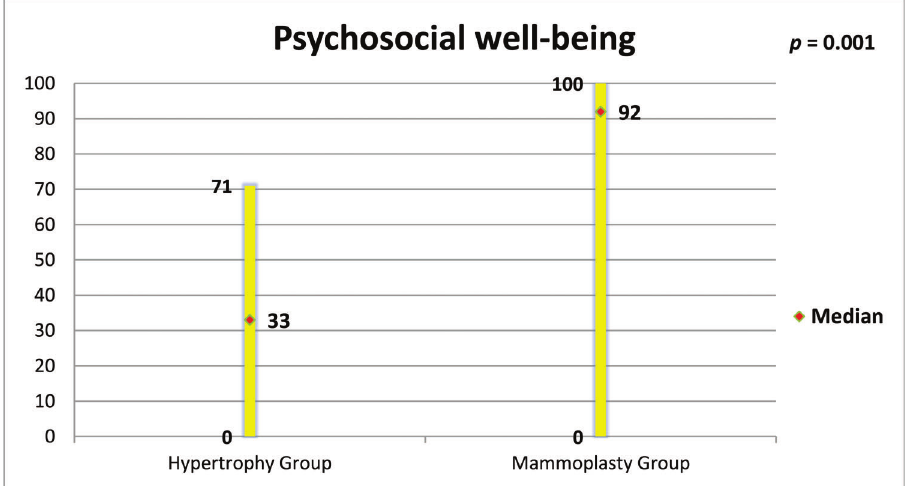
Figure 6 - Scores of BREAST-Q s subscale ‘‘ Psychosocial well-being ’’ in both groups and comparison by the Mann-Whitney test.